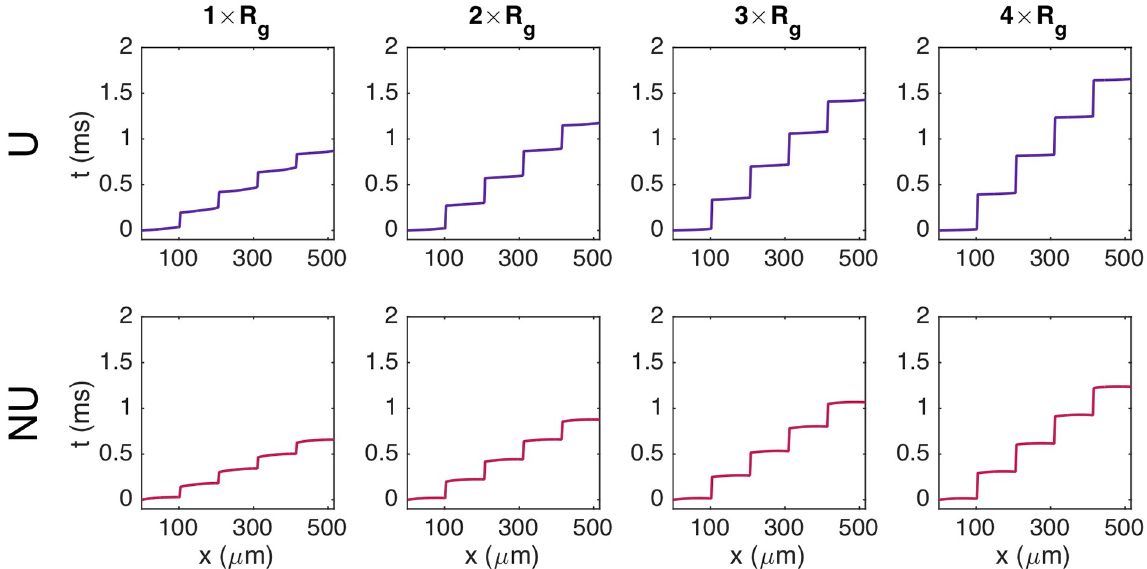
Fig 5. Illustration of discontinuous conduction for a uniform (U) and a non-uniform (NU) distribution of sodium channels. The plots show the time at which each of the x -values along the membrane of the five center cells in a simulation of a strand of seven cells first reach a membrane potential of v = 0 mV. The title above each panel indicates the factor with which the default value of R g = 0.0045 k O cm 2 is multiplied in the simulation. The remaining parameter values are specified in Table 1, except that the time step is set to Δ t = 0.0005 ms.